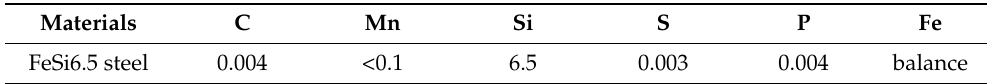
Table 1. Chemical composition of steels,